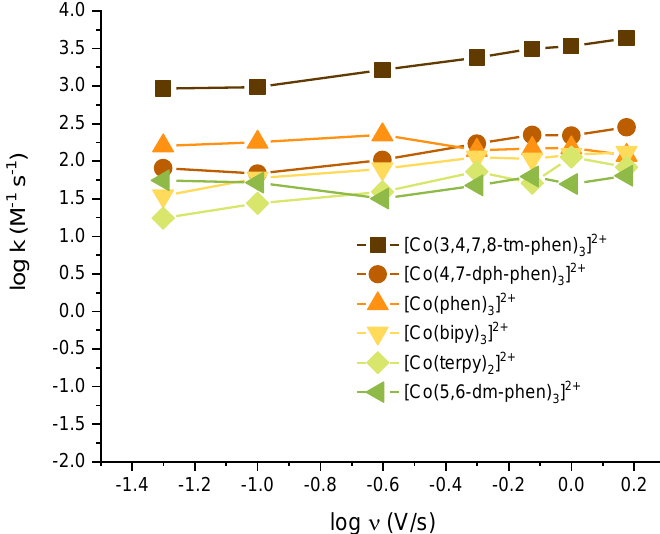
Figure 12. Rate constant as a function of log v for the Co(II) compounds studied in this